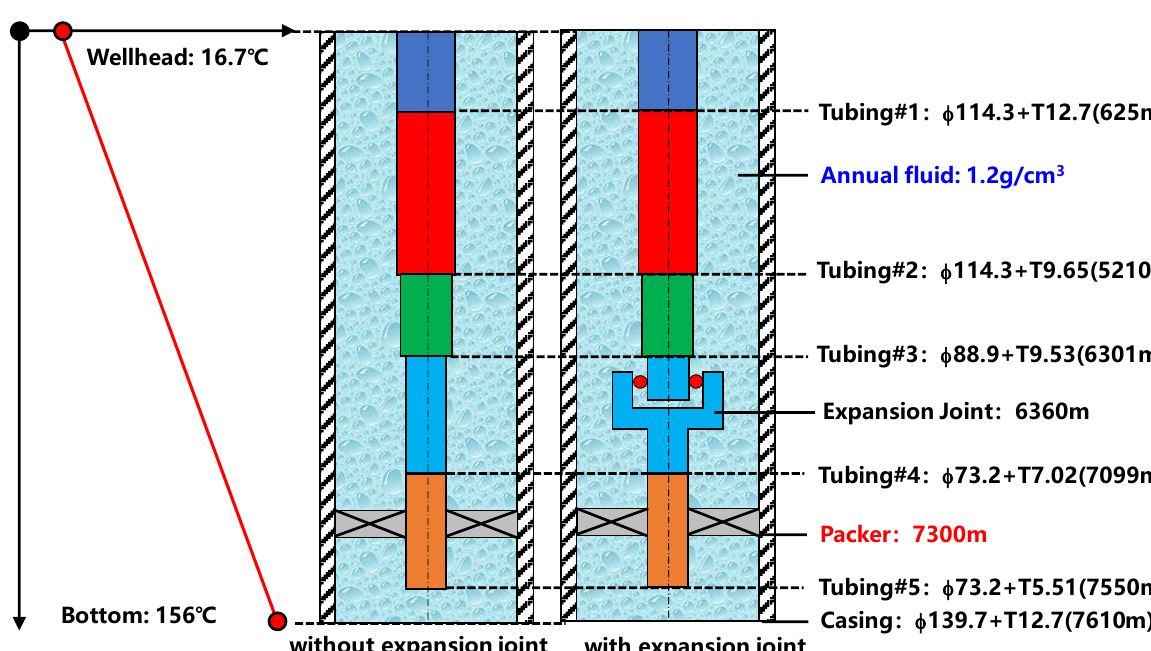
Figure 6. The FE model of whole section tubing string casing.